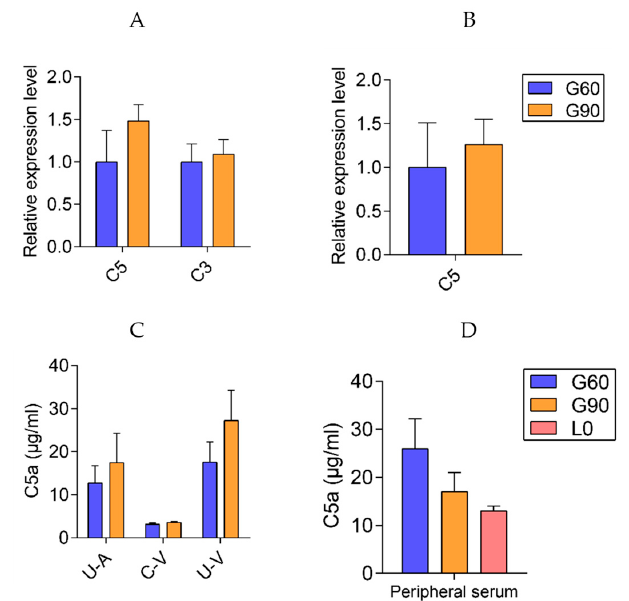
Figure 7. The complement system in livers and placentas. The expression of hepatic complement C3 and C5 ( A ) and placental complement C5 ( B ) between G60 and G90 determined by qRT-PCR, n = 3–6 / group. ( C ) The concentrations of complement C5a in U-A, U-V, C-V serum between G60 and G90, n = 5–6 / group. ( D )The concentrations of complement C5a in maternal peripheral serum, n = 10 / group. U-A, uterine artery, C-V, umbilical cord vein, U-V, uterine vein. Data are shown as means ±